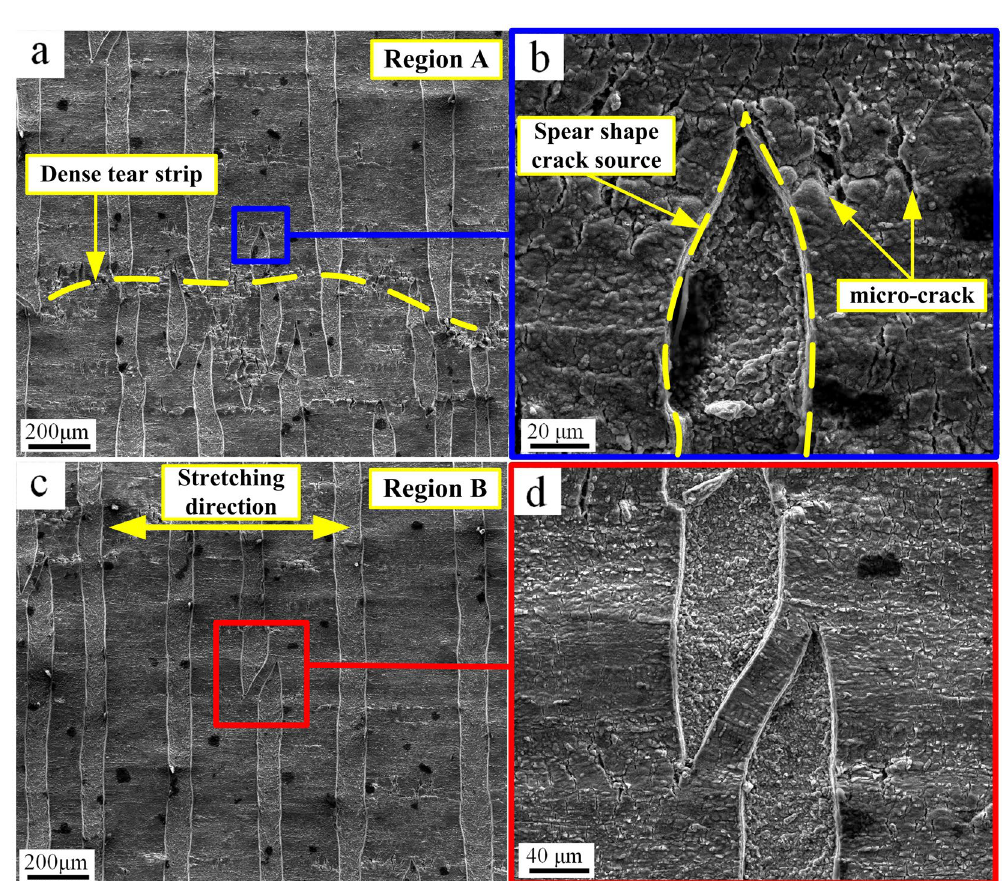
Figure 2. ND surface tear strip; ( a ) SEM morphology of region A in Fig. 1(a); ( b ) tear source morphology; ( c ) SEM morphology of region B in Fig. 1(a); ( d ) tear strip